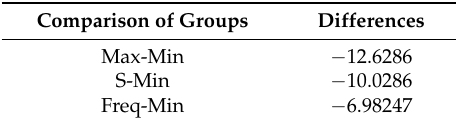
Table 6. Significant results to 95% of the multiple range test (LSD) for %W according to. Comparison of Groups Differences